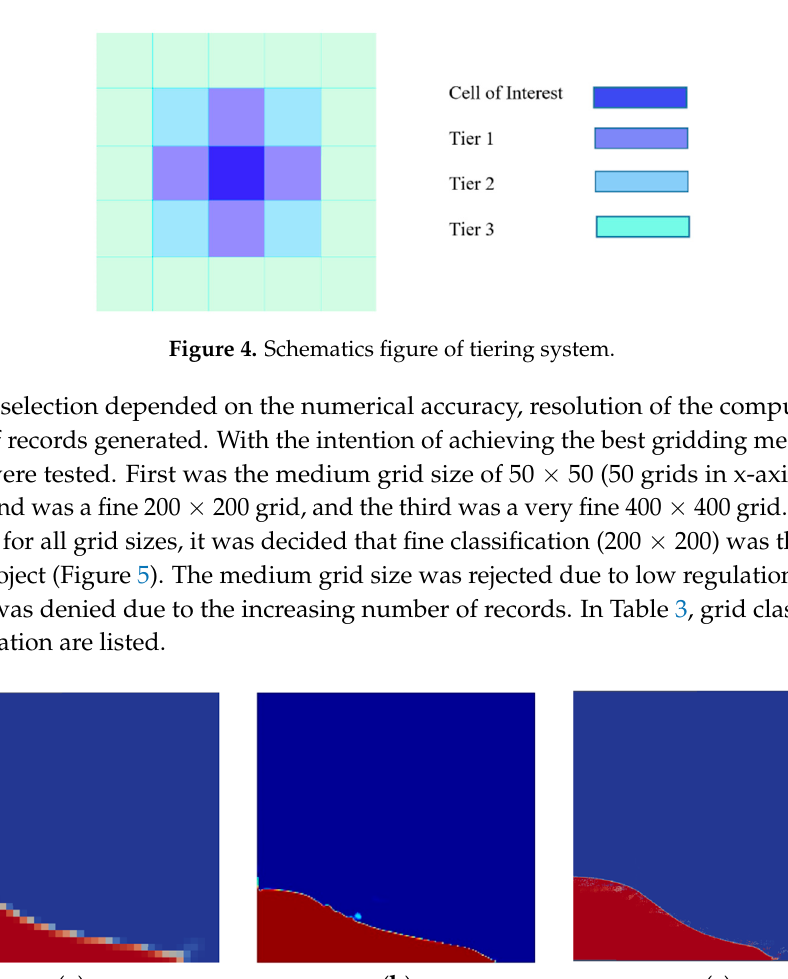
Figure 5. ( a ) Medium mesh with 50 × 50 grids, ( b ) fine mesh with 200 × 200 grids, ( c ) very fine mesh with 400 × 400 grids. Table 3. Grid